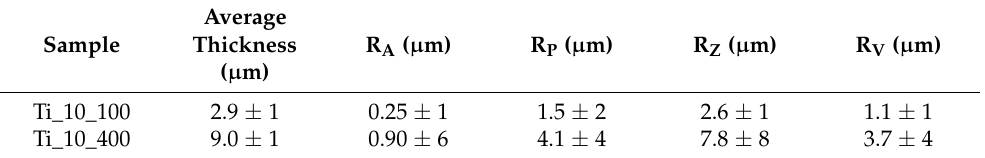
Figure 8. Roughness of the Ti_10_100 sample. Table 5. Comparisons of thickness and roughness of deposited